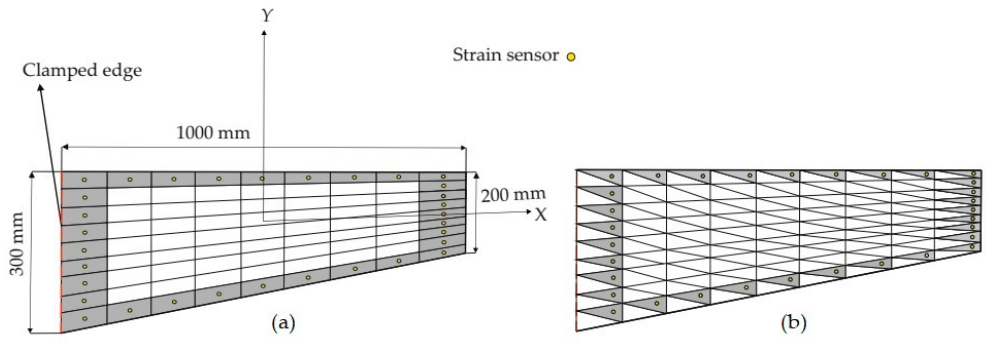
Figure 3. ( a ) Dimensions of the tapered plate with sensor placement model on iQS4/iCS8 mesh and ( b ) iMIN3 mesh. ( b ) iMIN3